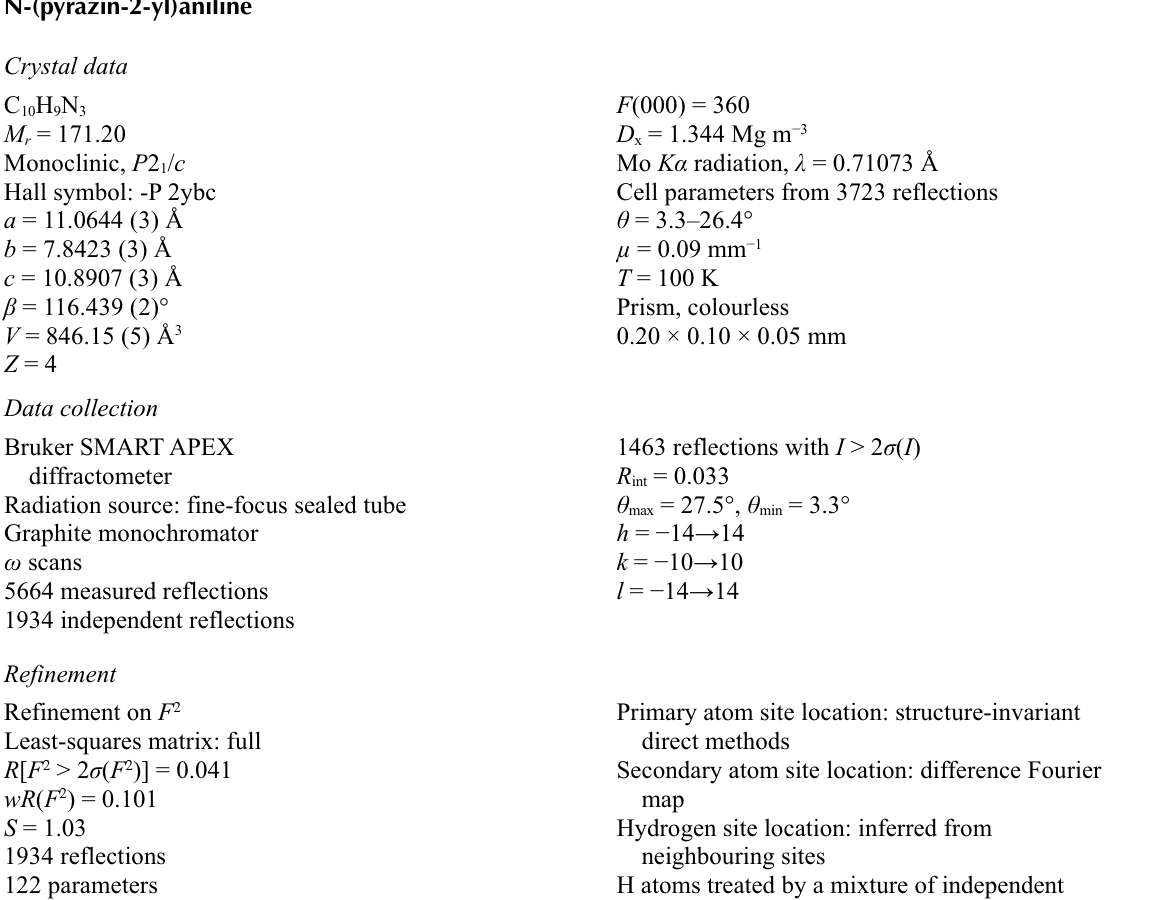
H N at the 70% probability level; hydrogen atoms are drawn as spheres of 10 9 3